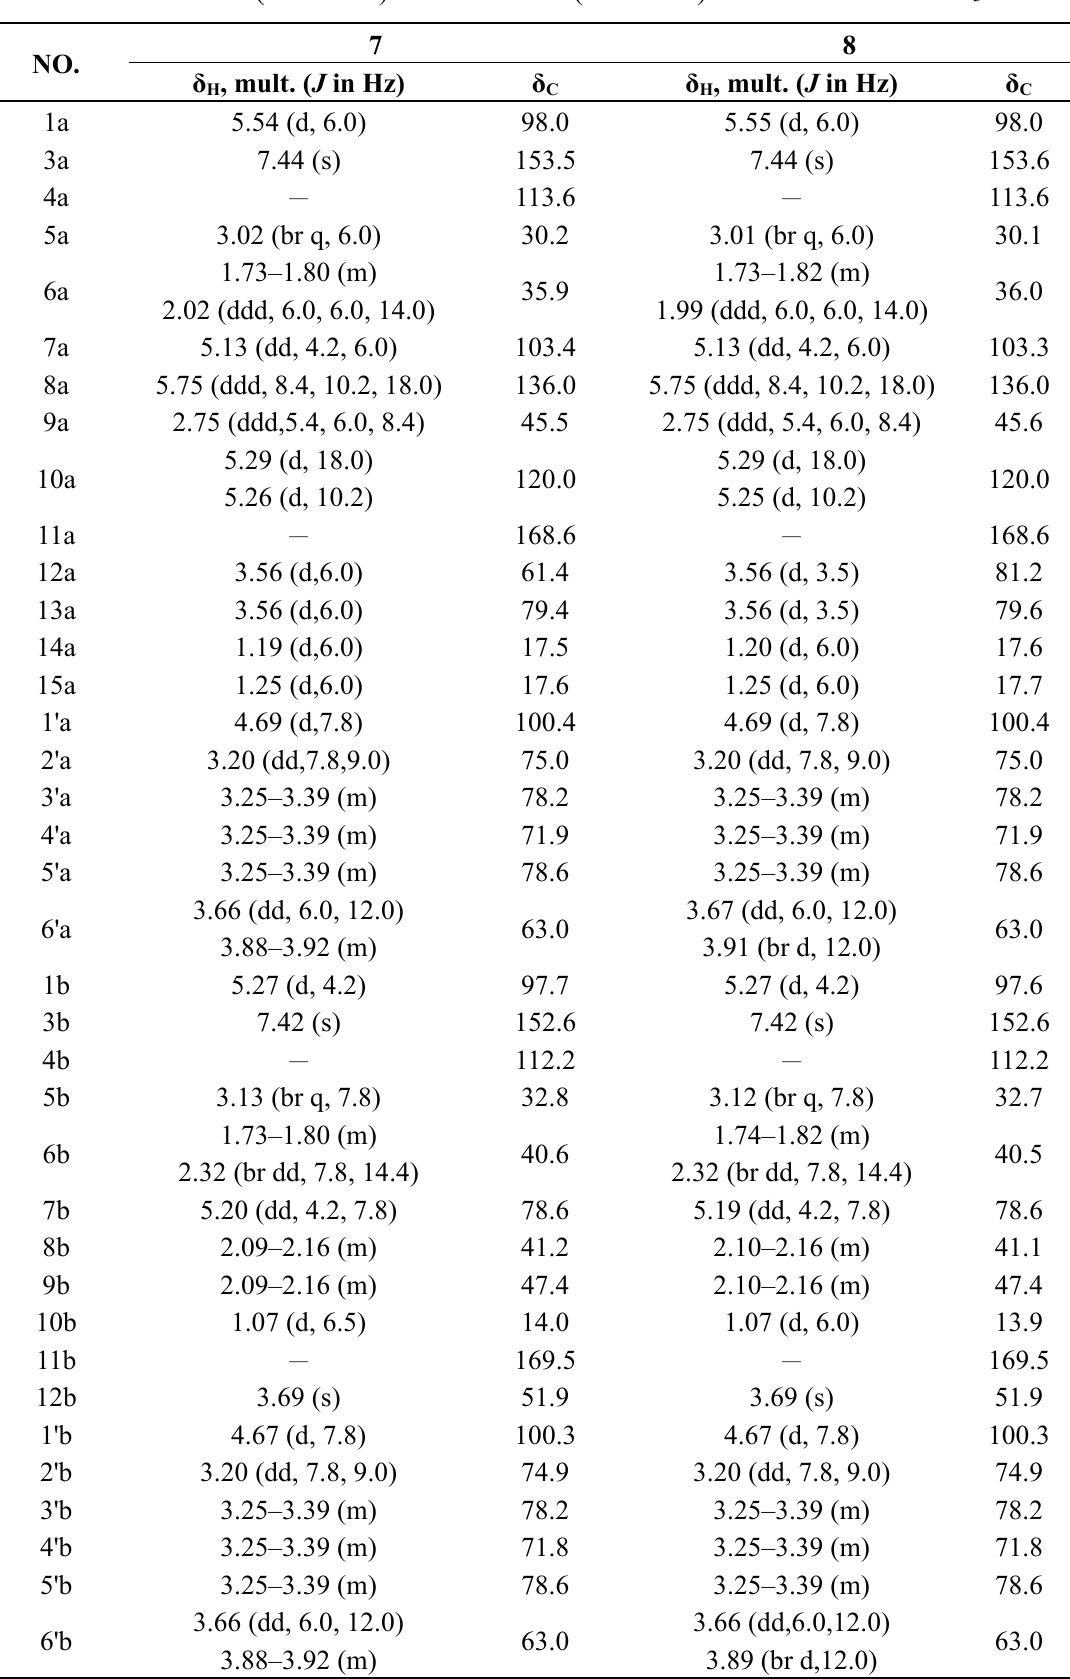
Table 2. 1 H-NMR (600 MHz) and 13 C-NMR (125 MHz) data of 7 and 8 in CD 3 OD.